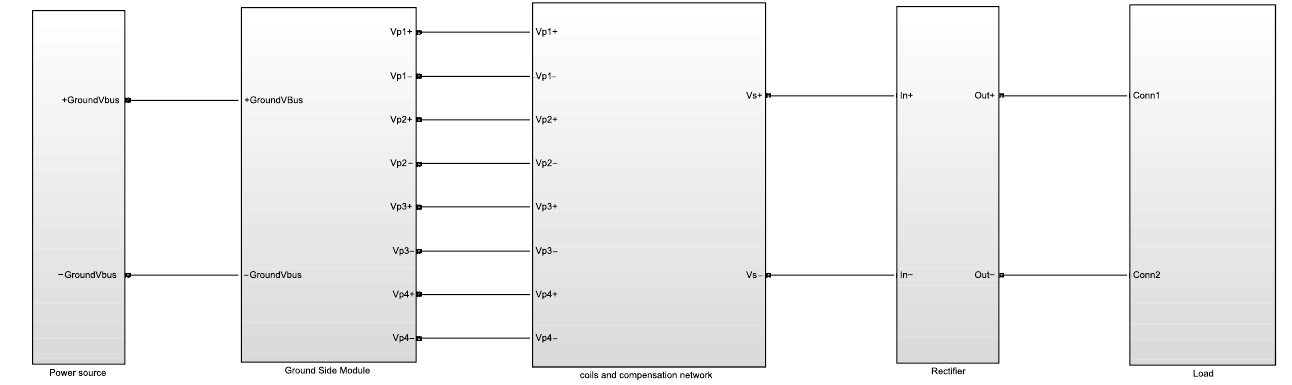
Figure 11. General block diagram of the MATLAB Simulink electrical model.